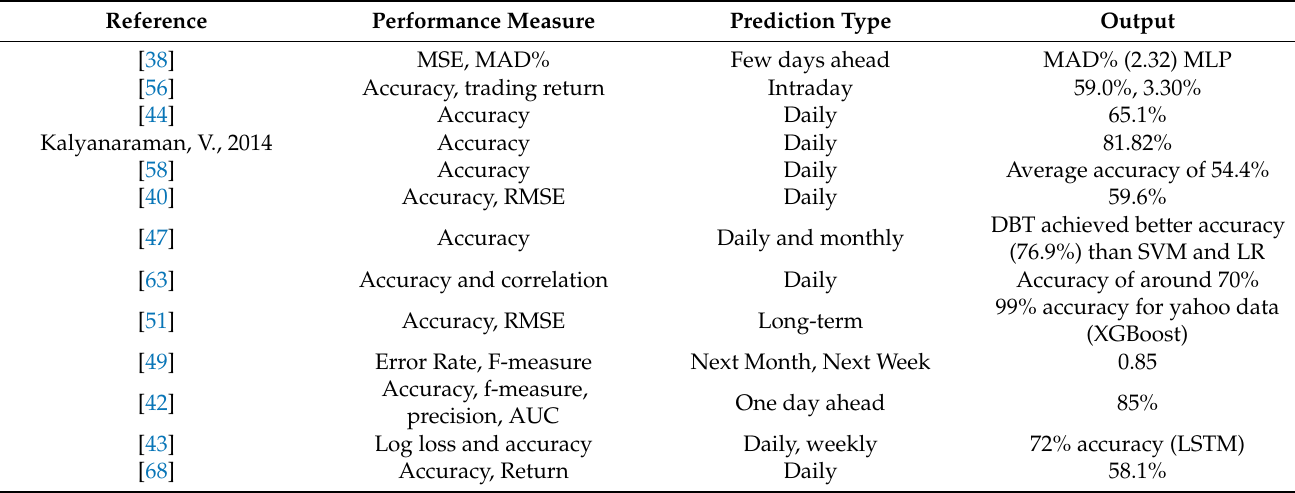
Table 4. Comparison of the evaluation metrics applied to different SMP